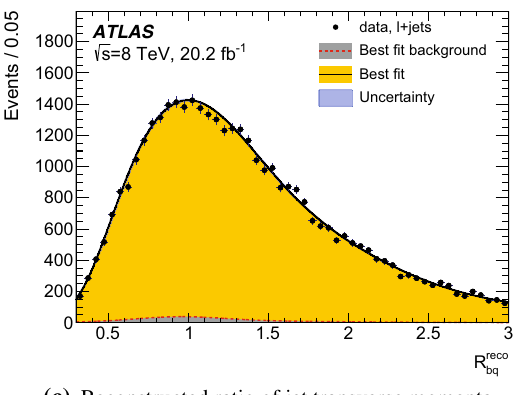
b top , and c W bq